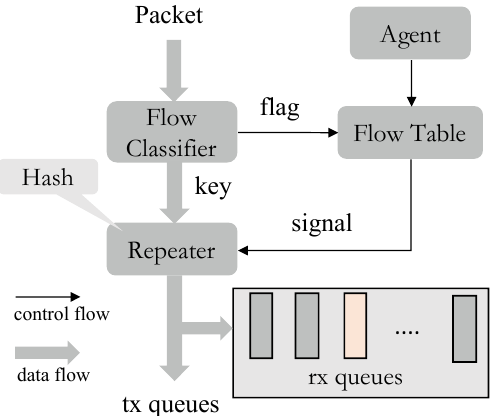
Figure 3. Multi-queue receiving